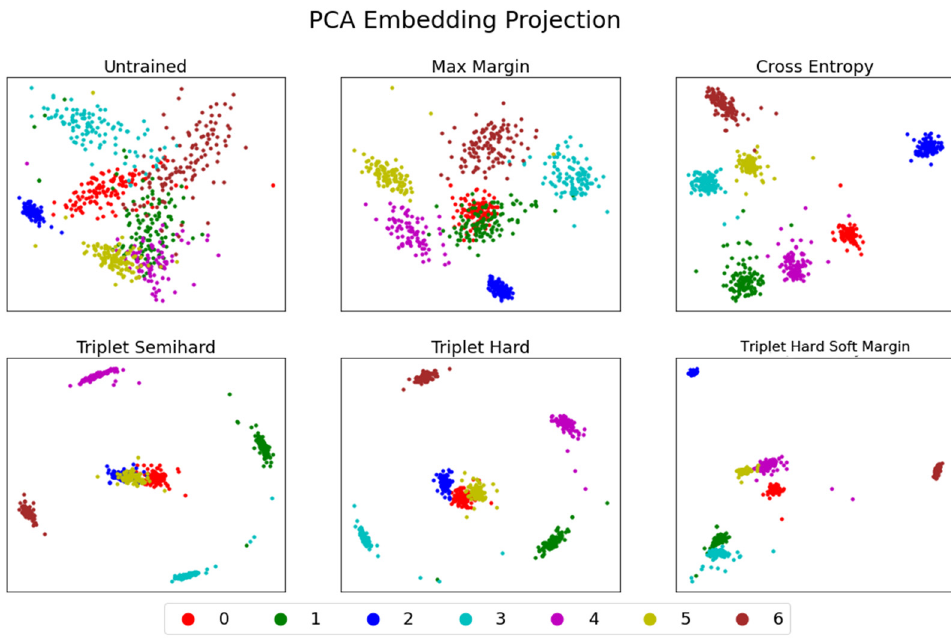
Figure 11. Comparison of principal component analysis (PCA) from embedding projections for all trained FEMs and untrained FEM.